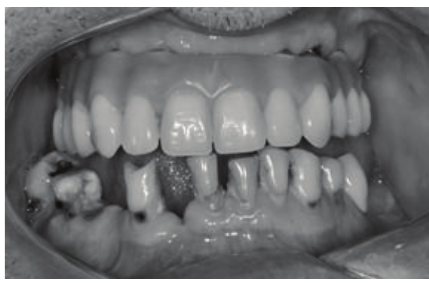
Figure 2: Impression of the abutments with the impression coping after extraction of the remaining teeth of the